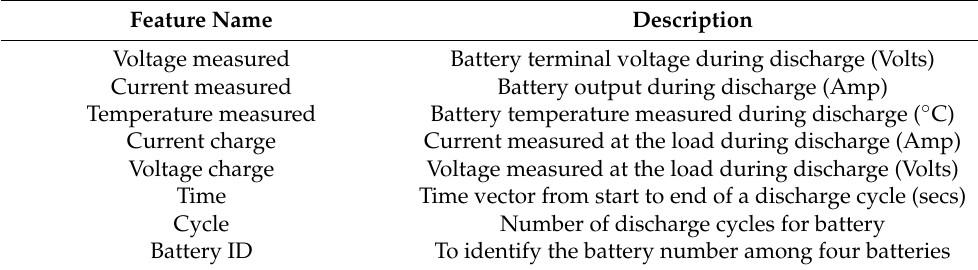
Table 2. Features corresponding to discharge profile in the Li-ion battery dataset.